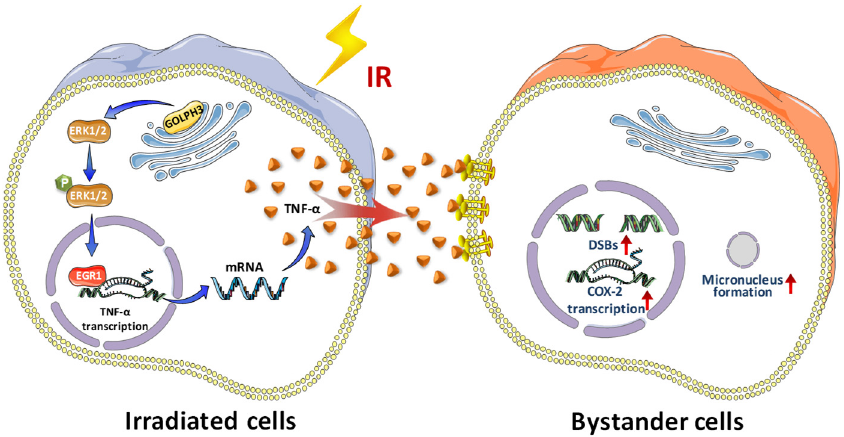
Figure 5. Schematic diagram of GOLPH3-mediated RIBE. In the irradiated cells, GOLPH3 modulates the activation of ERK1/EGR1 pathway to promote the transcription of TNF- α ; the secreted TNF- α from the irradiated cell acts as an intercellular signal molecule to mediate the induction of